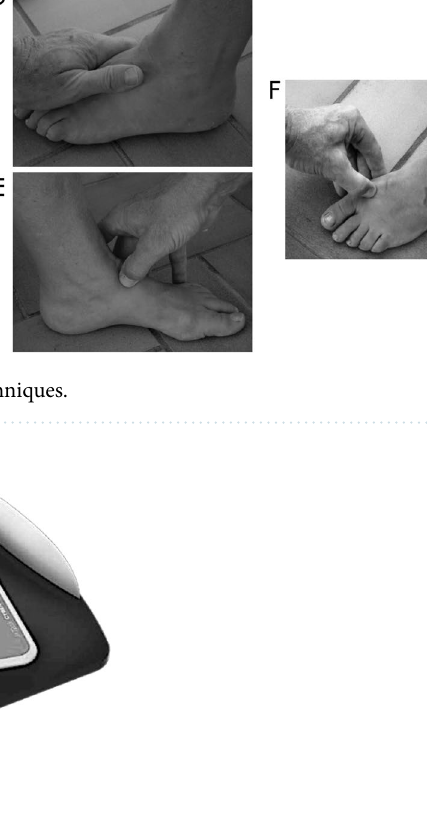
Figure 2. Two distinct synchronized patented dynamometric platforms, one for each foot, constitute the Cyber-Sabots. The silk-screened markings of each foot sole upon the two mono plates enable proper placement according to the patient feet size, maximizing